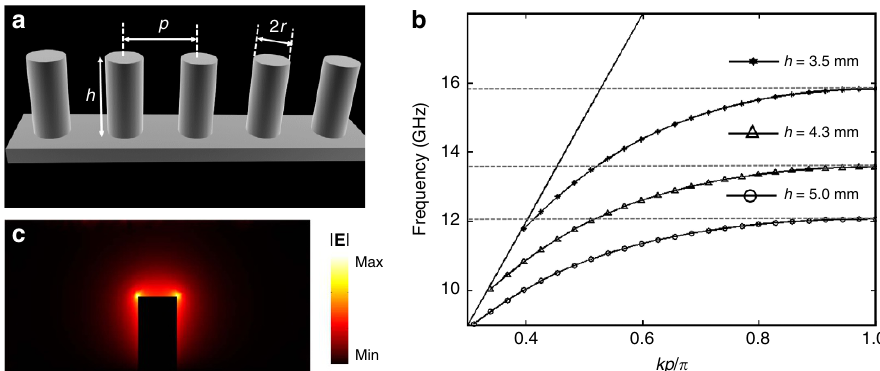
Figure 3 | Dispersion and field profile of designer surface plasmons. ( a ) Schematic of an array of metallic rods on a flat metallic surface. ( b ) Dispersions of designer surface plasmons with heights of rods h ¼ 3.5mm (star curve), h ¼ 4.3mm (triangle curve) and h ¼ 5.0mm (circle curve), respectively. The black solid line is the light line. ( c ) Mode profile of | E | field in the cross-section of a metallic rod that is perpendicular to the wave-guiding direction ( h ¼ re-open with topologically protected edge states, while the Chern numbers of all bands are still zero 22 . Fig. 3b. The mode profile of the electric field, for h ¼ 5.0 mm, is shown in Fig. 3c. We observe that the fields are tightly confined around the rods; other choices of h give similar mode profiles.